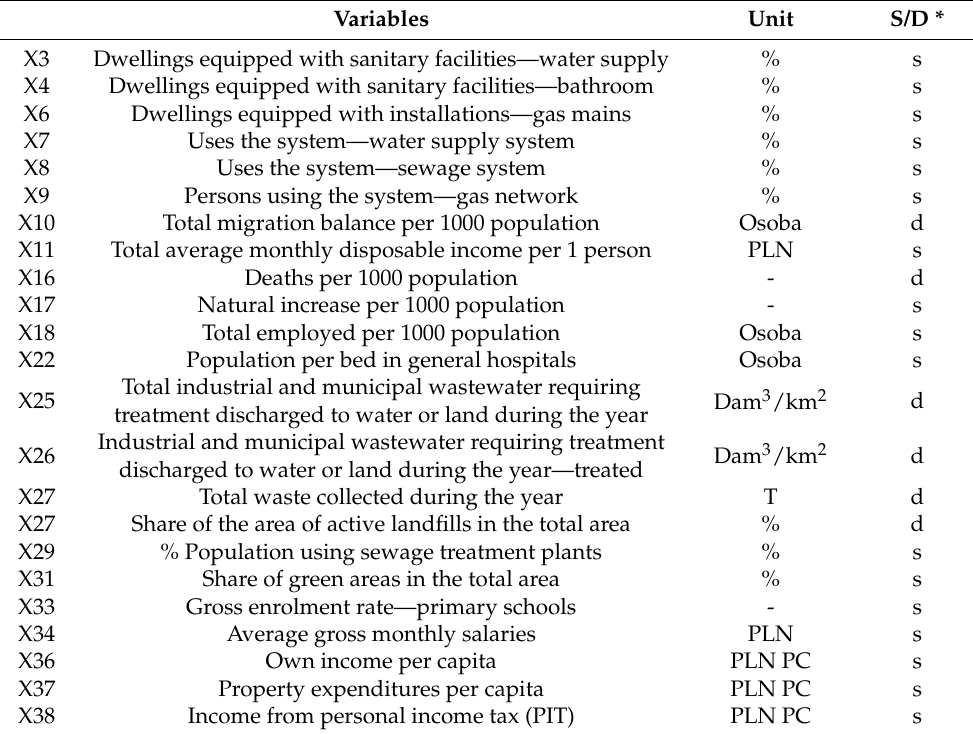
Table 1. List of variables describing the quality of life.